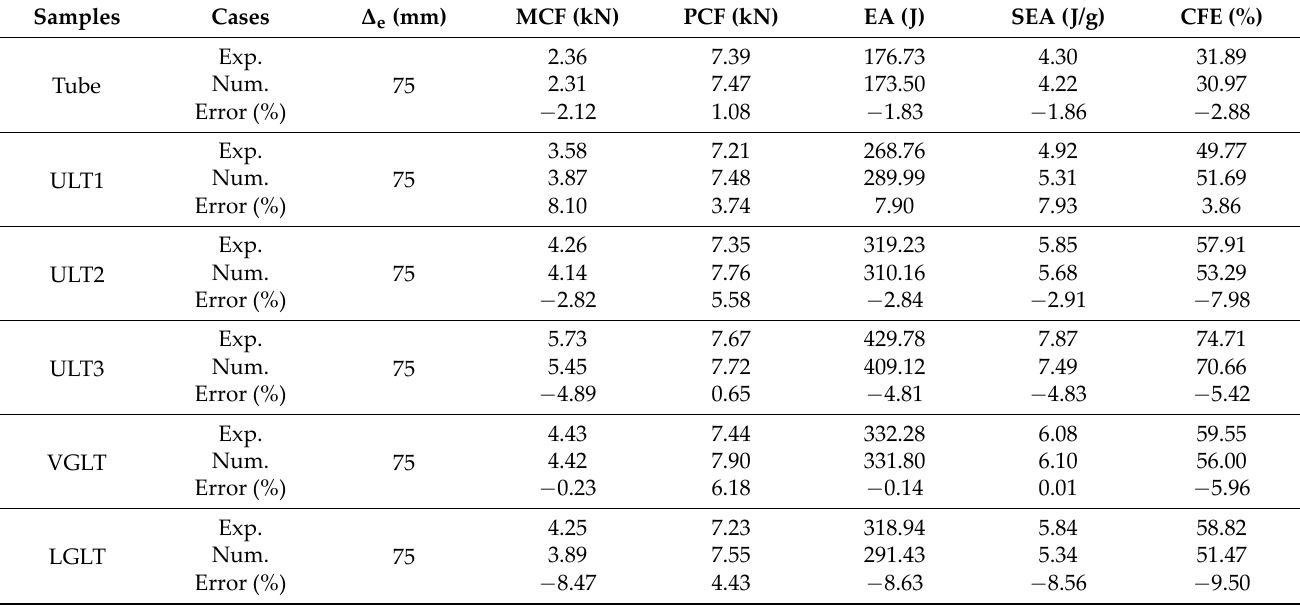
Table 4. Number of impact resistance indexes of experimental